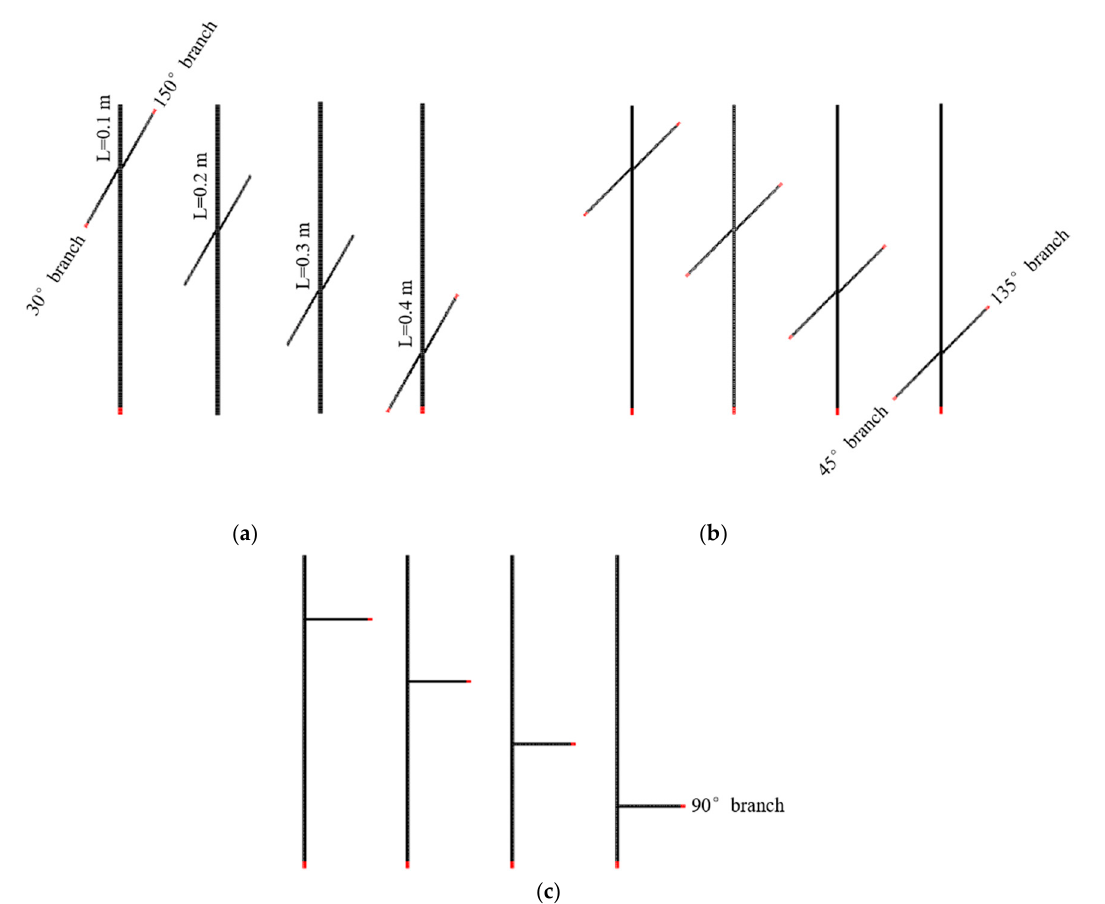
Figure 9. Sketch of the computational geometries with branches at different locations, ( a ) 30°–150°- Figure9. Sketchofthecomputationalgeometrieswithbranchesatdifferentlocations,( a )30–150 ◦ -branches, branches, ( b ) 45°–135°-branches, ( c ) 90°-branch. ( b ) 45–135 ◦ -branches, ( c ) 90 ◦